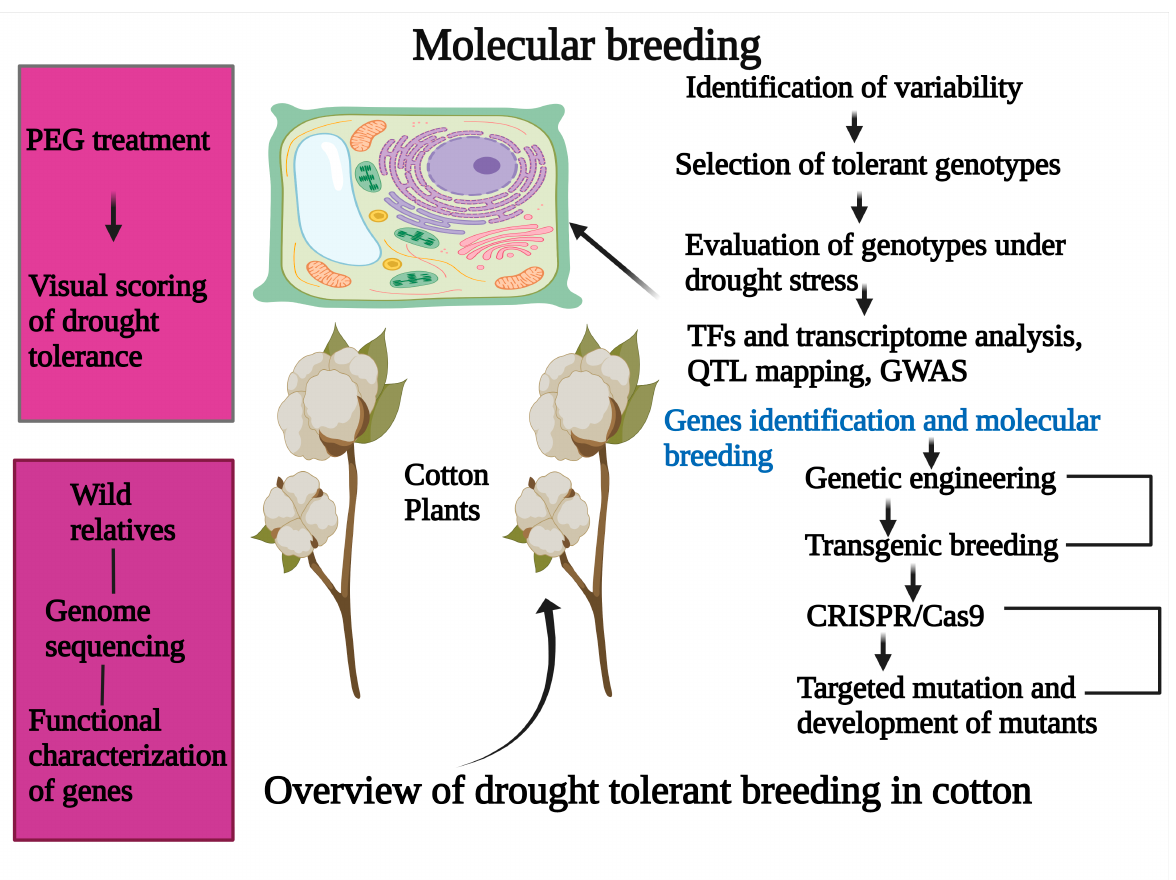
Figure 3. Drought-tolerant cotton genotypes can be developed using different breeding